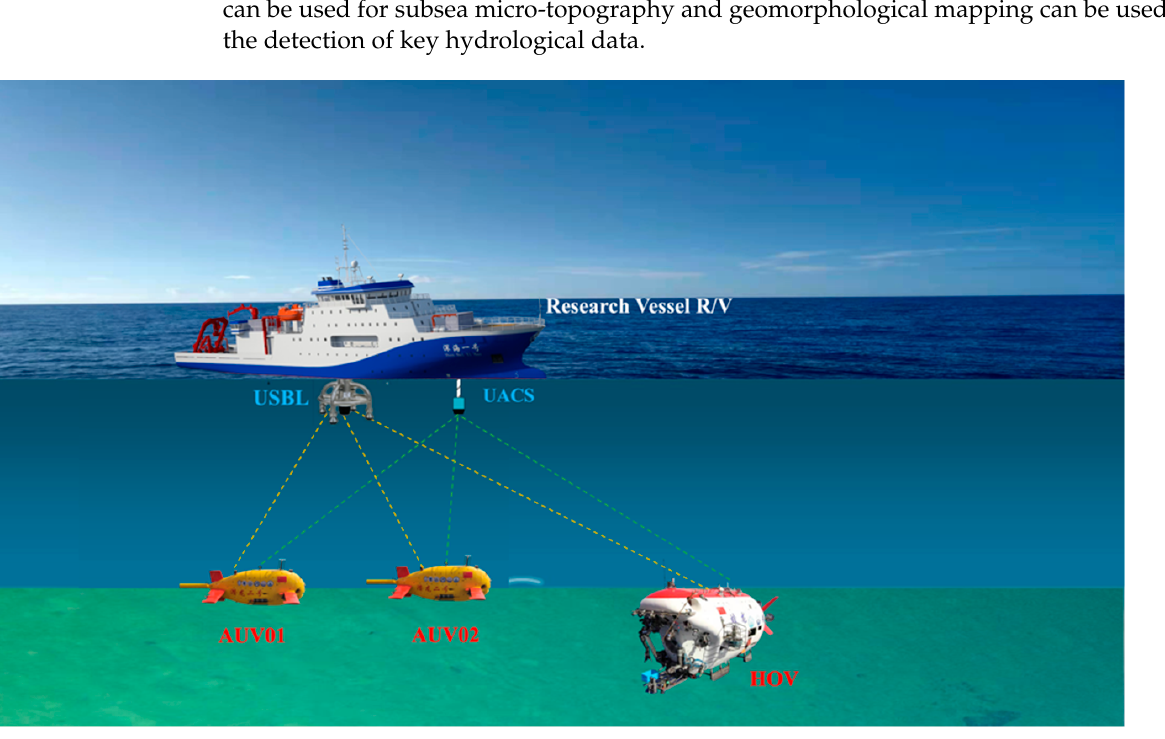
Figure 4. Scenario of a cooperative operation based on the pure research vessel R/V.